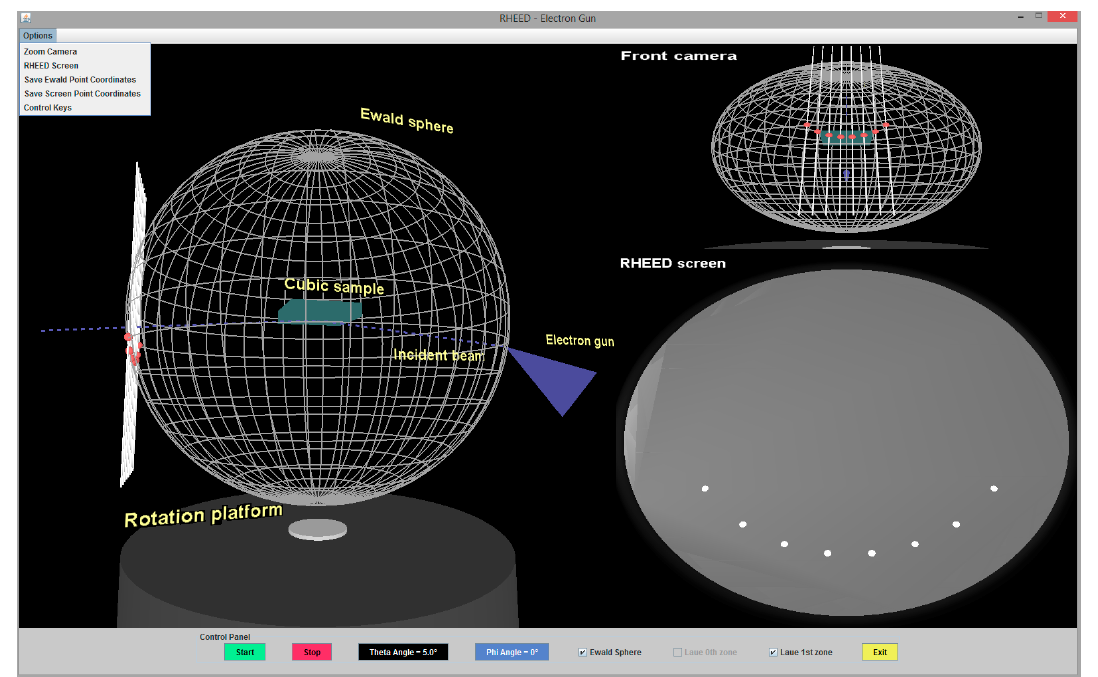
Figure 3. Snapshot of the application for drawing the Ewald sphere and finding the distribution of spots at the screen.